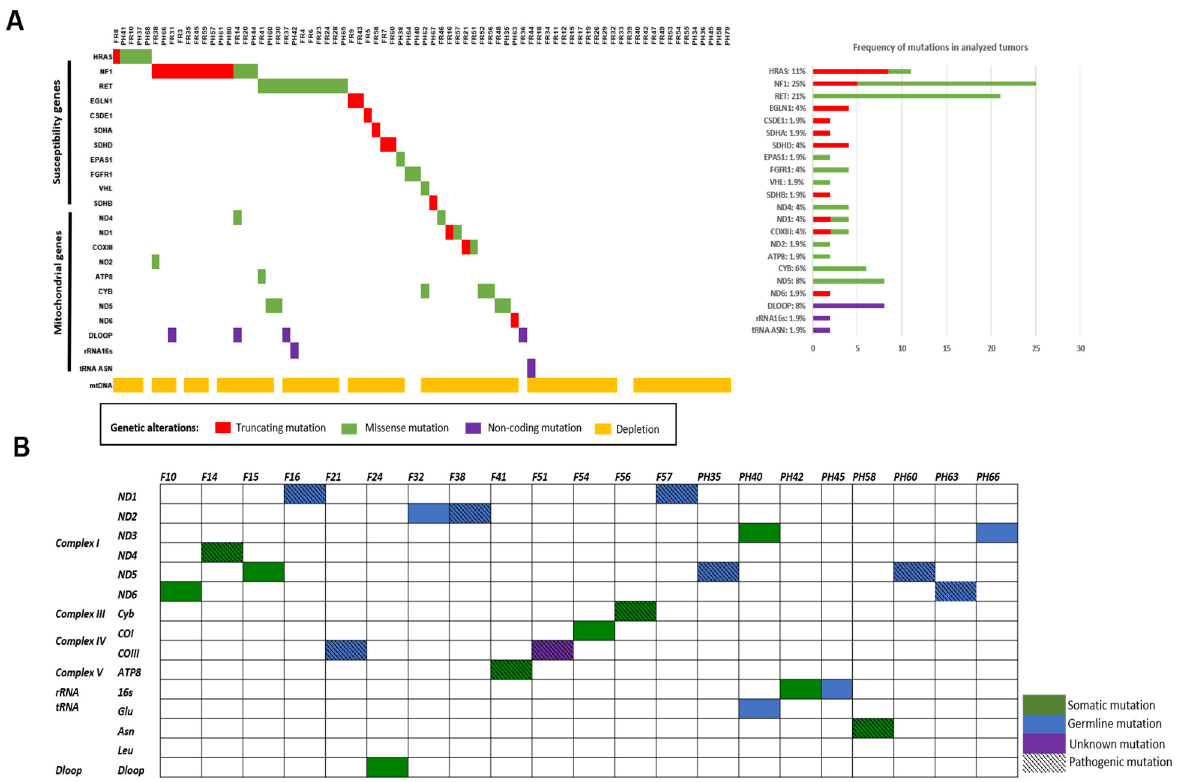
Figure 1. Mutation’s analysis. ( A ) OncoPrint summarizing the distribution of nuclear and mitochondrial pathogenic mutations, and mitochondrial depletion in PCC/PGL tumors with total mutation frequencies. The OncoPrint showed an overview of genomic alterations (legend) in particular genes (rows) affecting individual samples (columns). The truncated, missense, and non-coding mutations are shown in red, green, and purple, respectively. Mitochondrial depletion is shown in yellow. ( B ) Summary of 21 novel gene mutations detected in 20 cases of PCCs/PGLs from France and Sweden; germline mutations are denoted by green color; somatic mutations are denoted by blue color, unknown mutations are denoted by purple color, and pathogenic mutations are denoted by hatch mark.